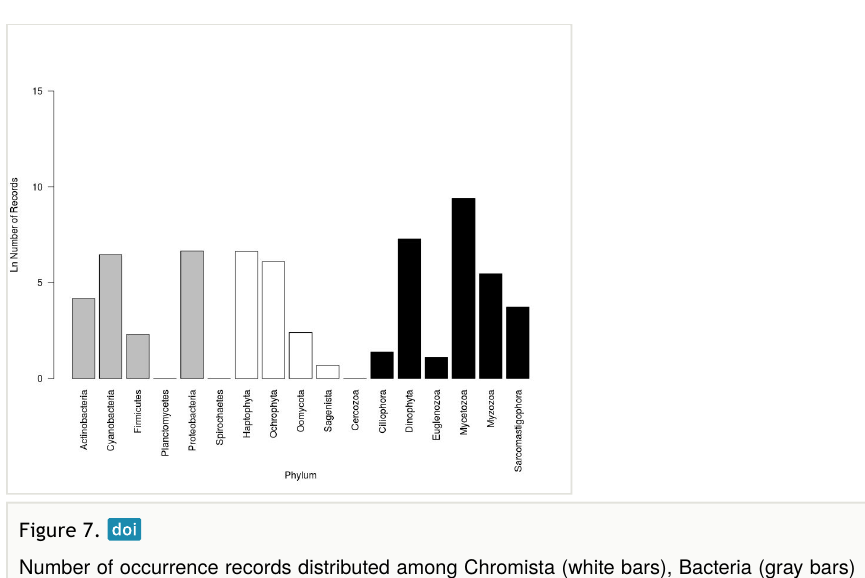
Figure 7. Number of occurrence records distributed among Chromista (white bars), Bacteria (gray bars) and Protozoa (black bars) kingdoms published outside national borders (logarithmic